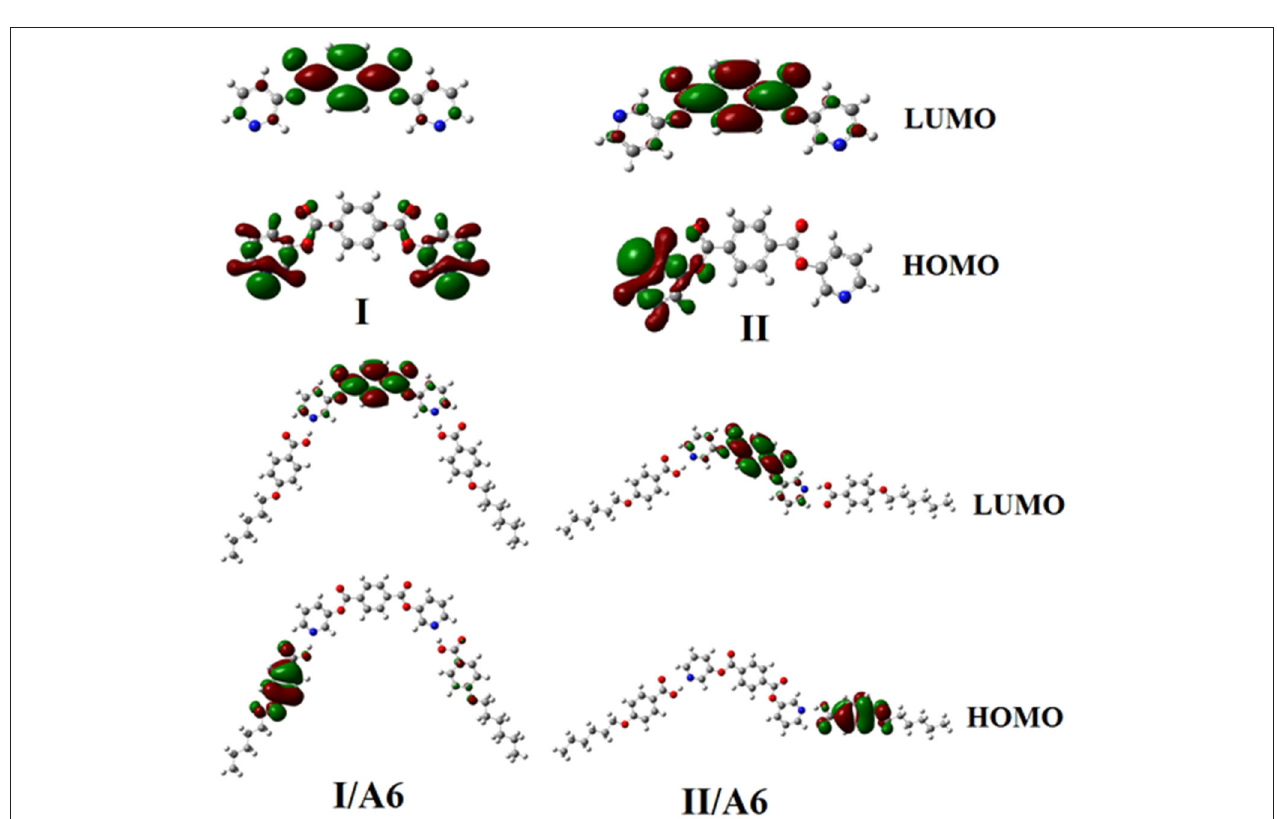
FIGURE 9 | Estimated plots for frontier molecular orbitals of both conformers of SMHBCs, I/A n , and II/A 6